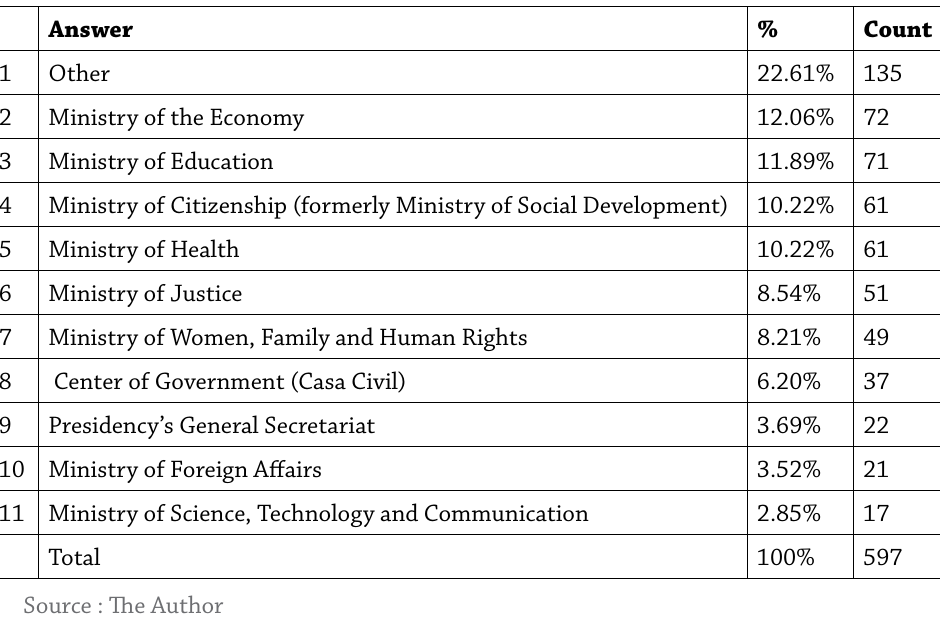
Table 1. Respondents’ current and former work institutions